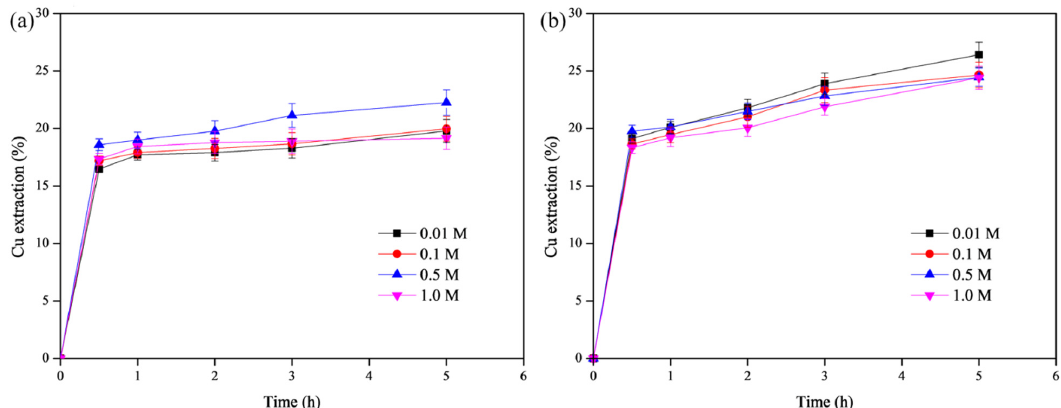
Figure 7. Copper extraction versus leaching time at four sulfuric acid concentrations ( a ) without and ( b ) with ultrasound assistance at 20% power amplitude (leaching conditions: 1% S/L, 50 °C, and 800 rpm stirring speed).